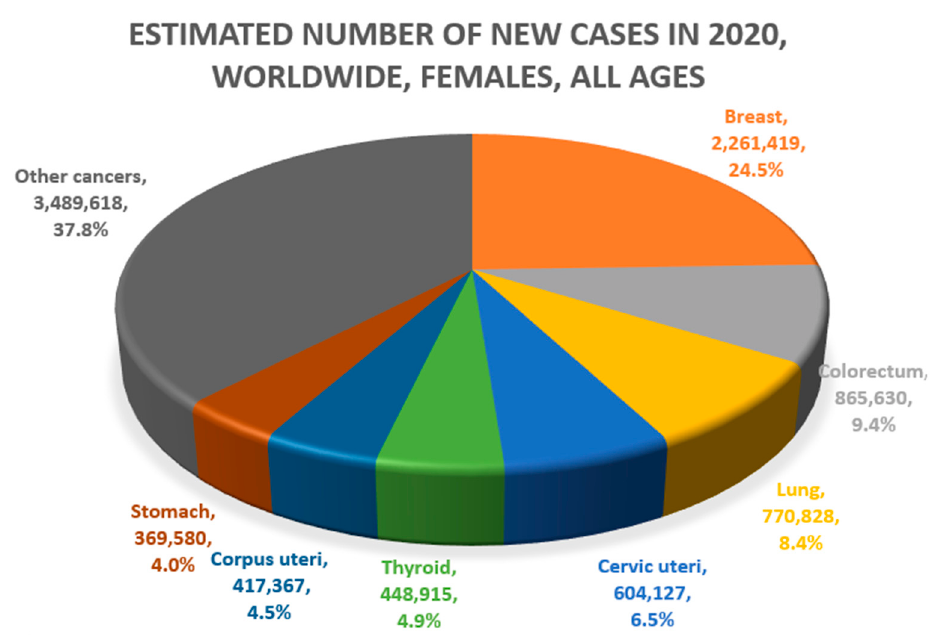
Figure 1. Common causes of cancer mortality in men ( above ) and women ( below ) (Data source: Global Cancer Observatory, GLOBOCAN 2020. Figures redrawn by authors) [4–7]. Global Cancer Observatory, GLOBOCAN 2020. Figures redrawn by authors)